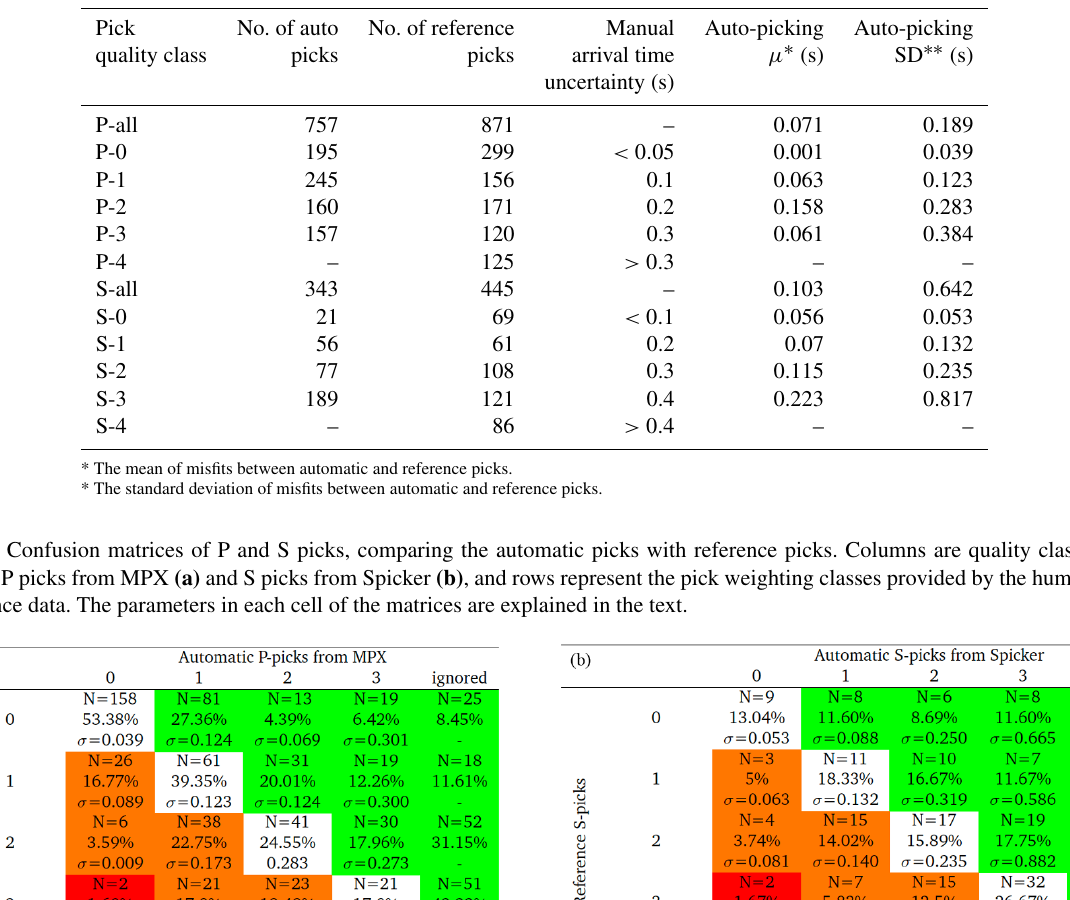
Table B2. Statistics of the automatic and reference picks associated with the quality classes for a dataset of 14 earthquakes. Pick No. of auto No. of reference Manual Auto-picking Auto-picking quality class picks picks arrival time µ ∗ (s) SD ∗∗ (s) uncertainty (s) P-all 757 871 – 0.071 0.189 P-0 195 299 < 0 . 05 0.001 0.039 P-1 245 156 0.1